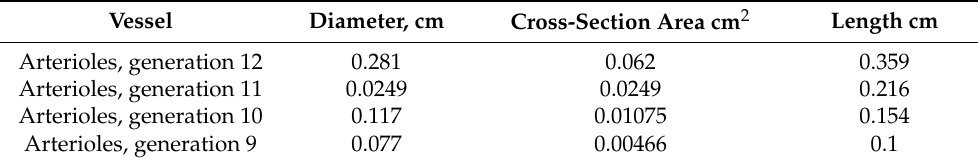
Figure 8. The graph of pulmonary vessels considered in the present work. The number above the vessel indicates the generation in the vessel tree [26]. The pulmonary tree starts from generation 1 corresponding to capillaries and ends with generation 15 corresponding to the main pulmonary artery leaving the right ventricle. Inflamed vessels in the 10th generation are shown in bold. Table 3. Parameters of the graph of pulmonary vessels. The diameters and length of the vessels are taken from [26]. The cross-section area is recalculated from the diameter. For all vessels, the maximal cross-section area s max and the minimal cross-section area s 0 are, respectively, 1.4 and 0.9 of the value given in the table [33]. The minimal pressure p 0 and maximal pressure p max equal 2 and 15 mm Hg, respectively [27]. In Equation (22), parameter θ = ( s max − s 0 ) / ( p max − p 0 ) . The initial pressure is 7 mm Hg for all vessels. The initial flux is 0.64 mL/s in level 12, which corresponds to the 80 mL/s in the main pulmonary